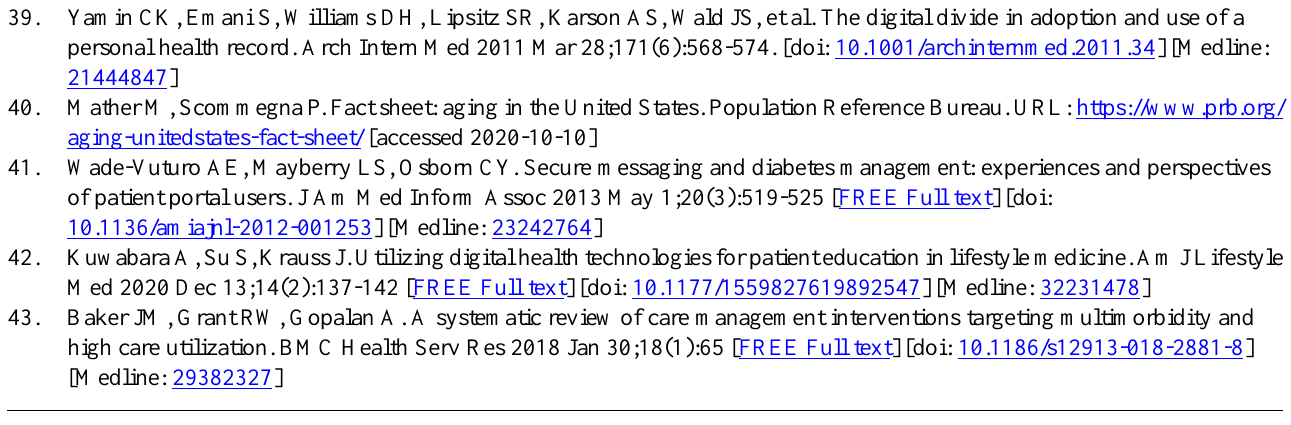
HINTS: Health Information National Trends